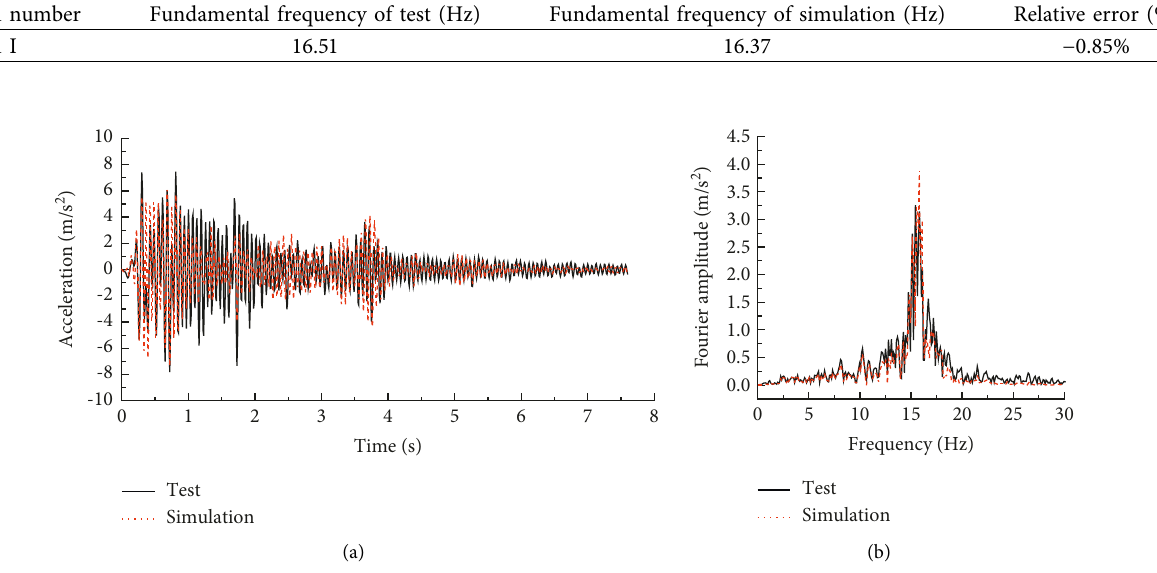
Figure 16: Comparison of acceleration of A8 under 0.30g scaled El Centro ground motion. (a) Acceleration time history. (b) Fourier